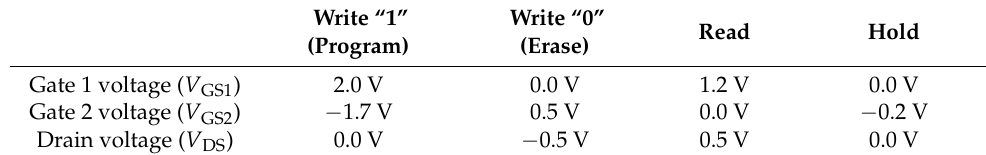
Table 2. Operating bias scheme for memory performance.